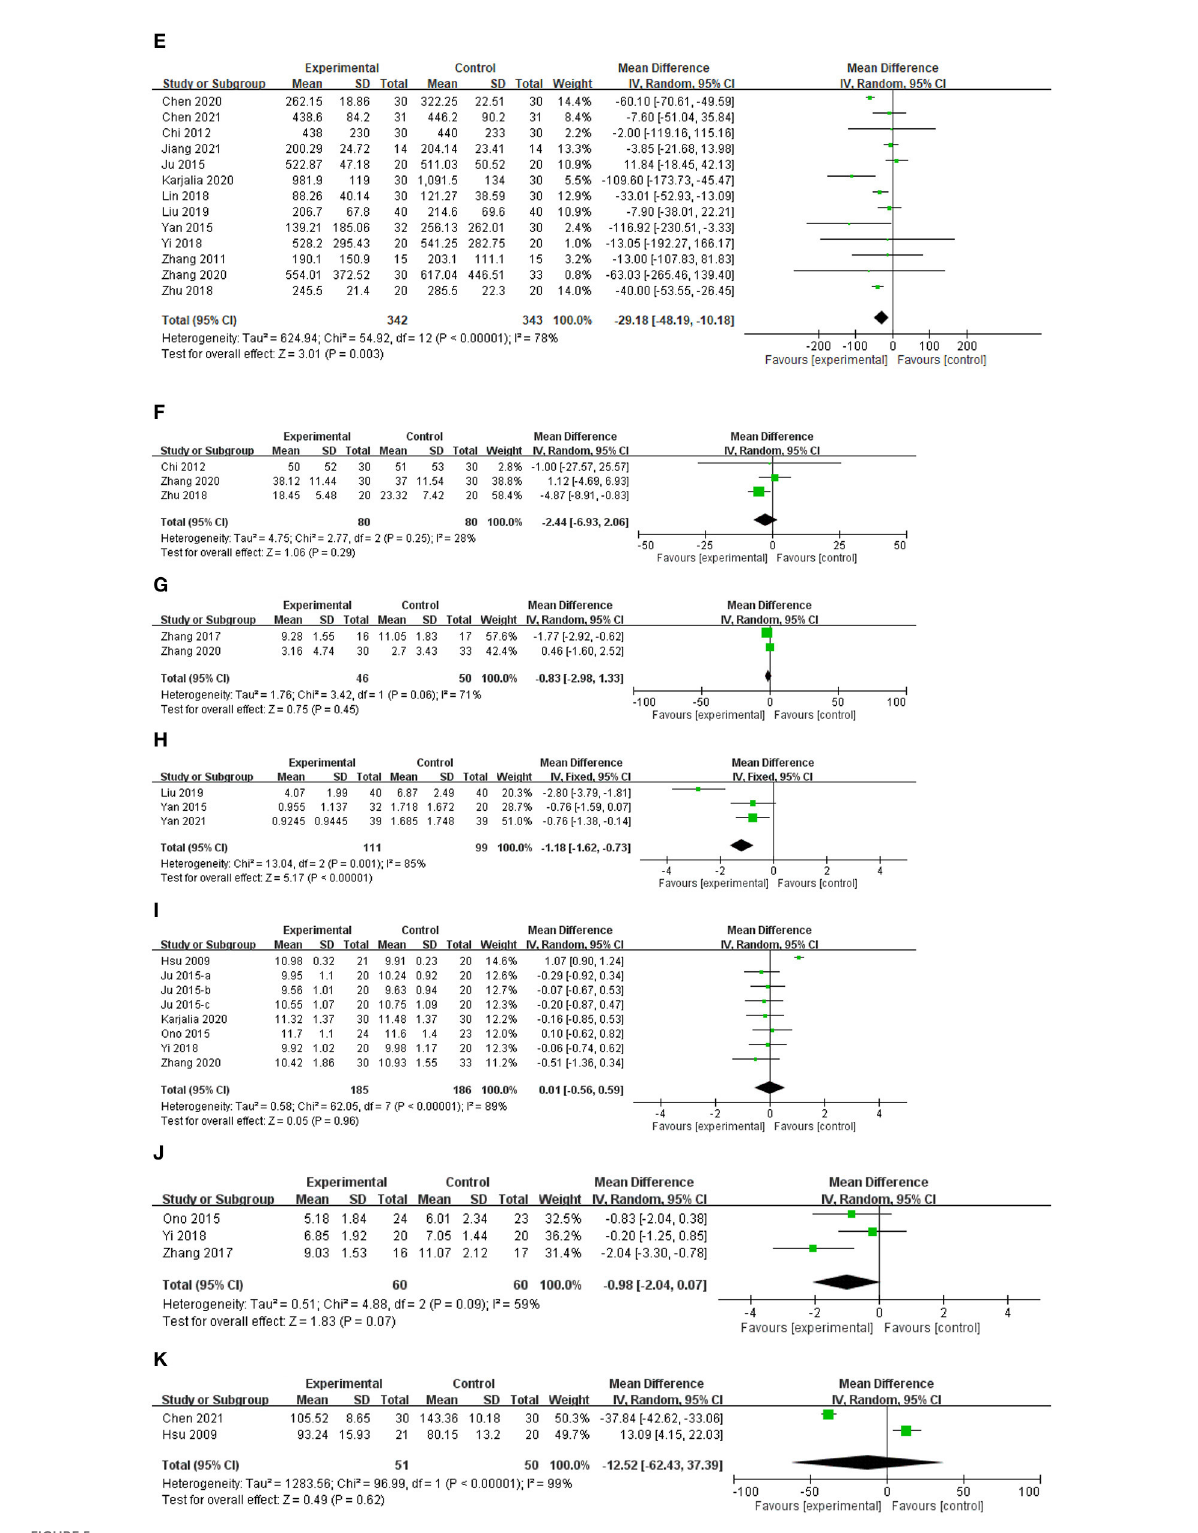
FIGURE5 Forest plot comparison of serum levels of (A) blood urea nitrogen, (B) creatinine, (C) calcium, (D) phosphate, (E) parathyroid hormone, (F) β 2-microglobulin, (G) C-reactive protein, (H) histamine, (I) hemoglobin, (J) white blood cells, and (K) alkaline phosphatase in patients with uremic pruritus treated with acupuncture or other related complementary therapies. CI, confidence interval; IV, independent variable; SD, standard